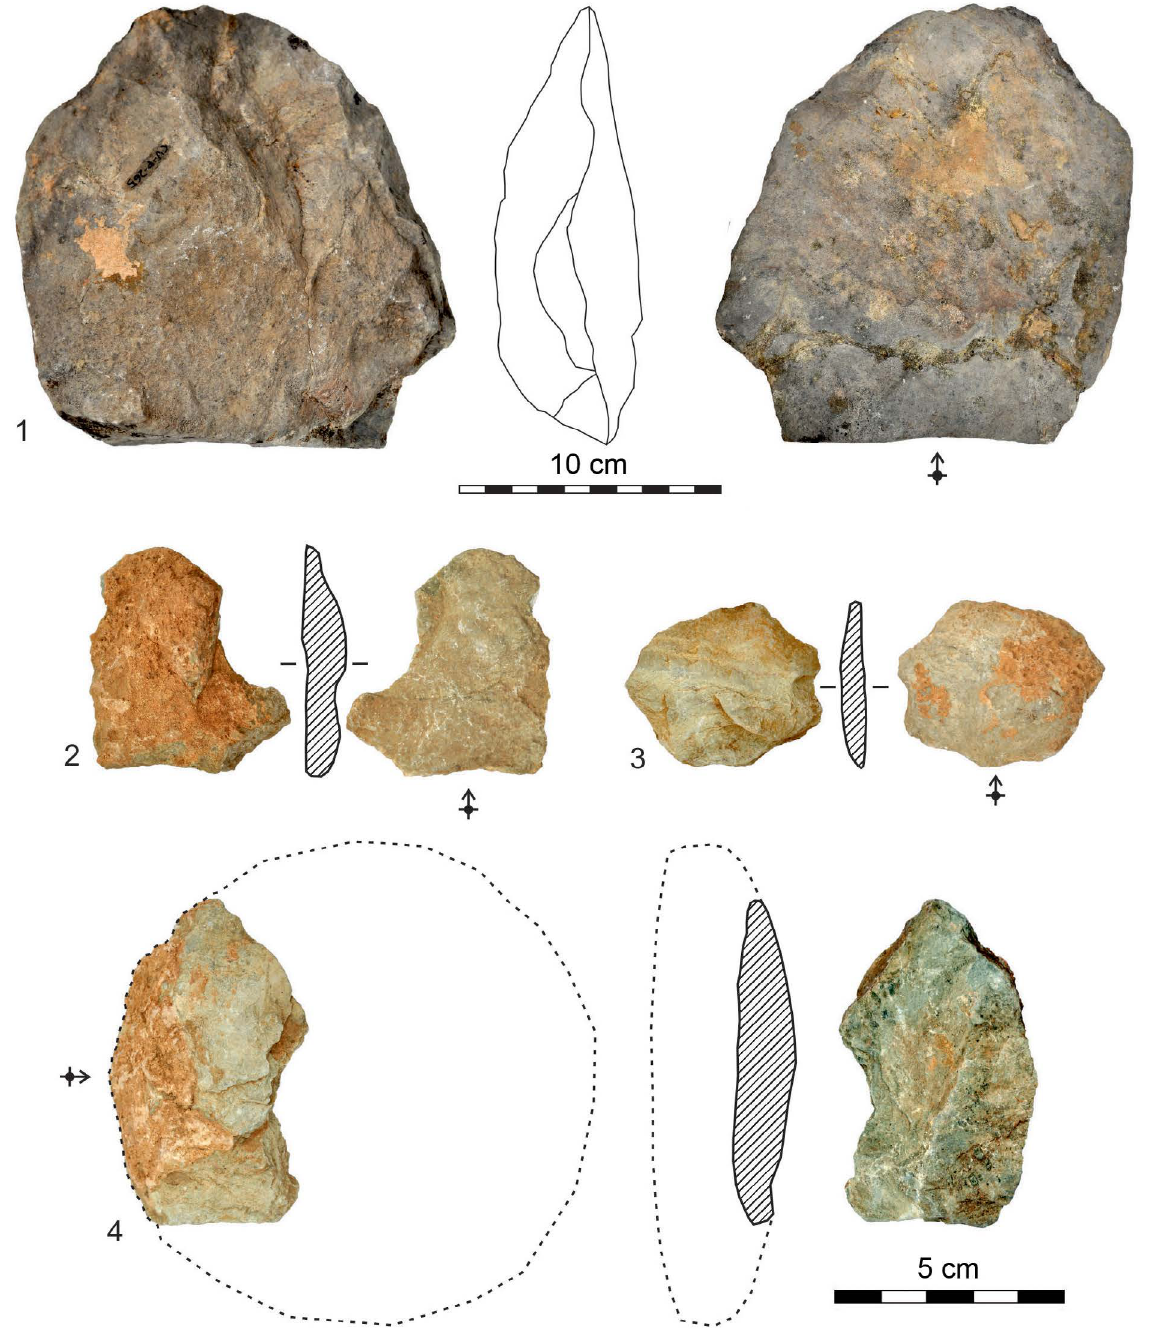
Figure 8. Different types of flakes determined in the quarry. 1. Large flake; 2 and 3. Percussion flakes; and 4. Preform